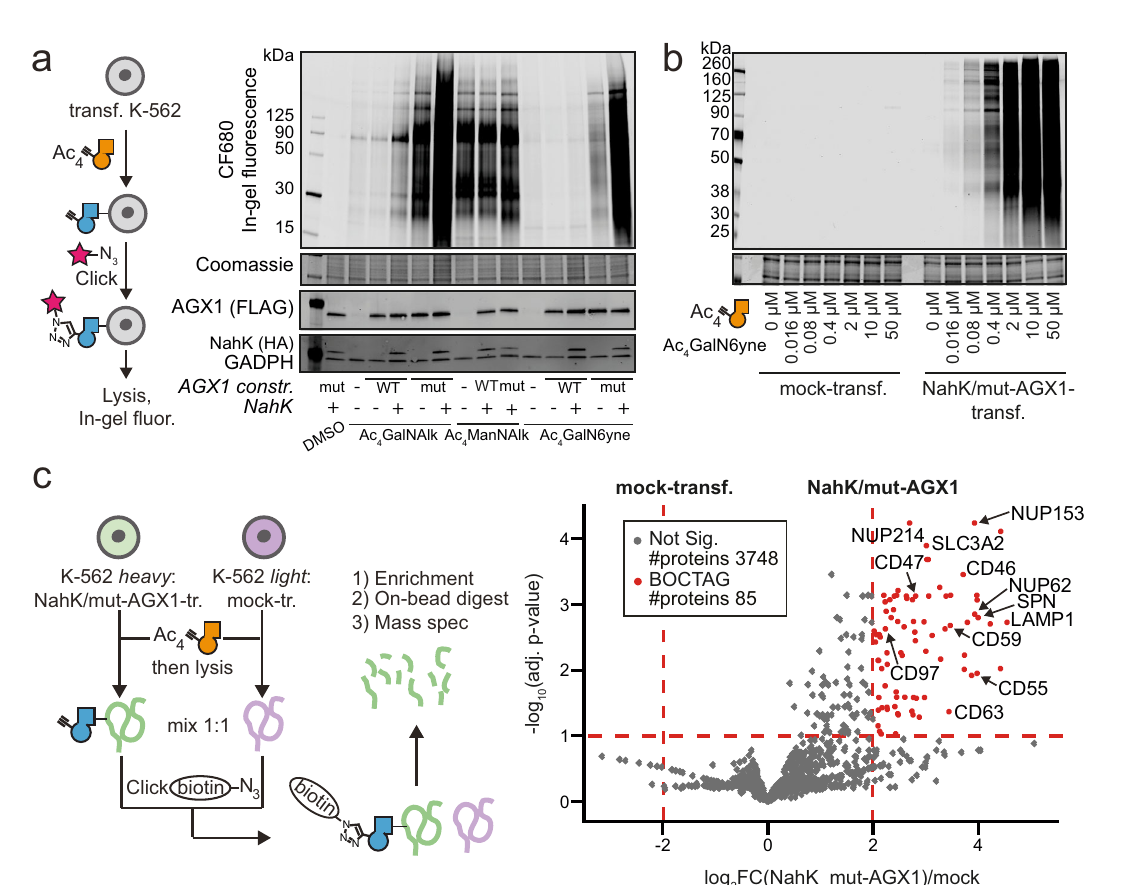
Fig.1|Developmentofanarti fi cialbiosyntheticpathwayforchemicallytagged UDP-GalNAc/GlcNAc analogues. a Strategy of metabolic oligosaccharide engi- neering.Achemicallymodi fi edGalNAcanaloguethatisnotacceptedbytheGalNAc salvage pathway should be processed by an arti fi cial biosynthetic pathway. B. longum NahK and mut-AGX1 biosynthesise UDP-GalNAc analogues and, by epi- merisation, UDP-GlcNAc analogues. Incorporation into glycoconjugates can be traced by CuAAC. b In vitro evaluation of GalNAc-1-phosphate analogue synthesis by human GALK2 or B. longum NahK (left) and UDP-GalNAc analogue synthesis by WT- or mut-AGX1 (right). Data were recorded in Liquid Chromatography-Mass Spectrometry (LC-MS) assays and processed by integrated ion counts against a